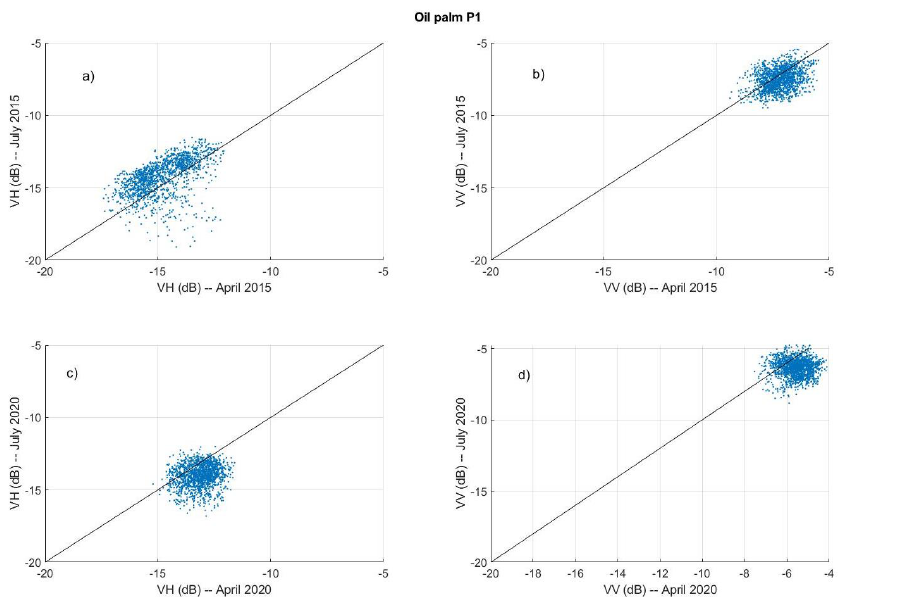
Figure 13. Scatter plots comparing wet and dry seasons in oil palm polygon P1: ( a ) VH 2015; ( b ) VV 2015; ( c ) VH 2020; and ( d ) VV